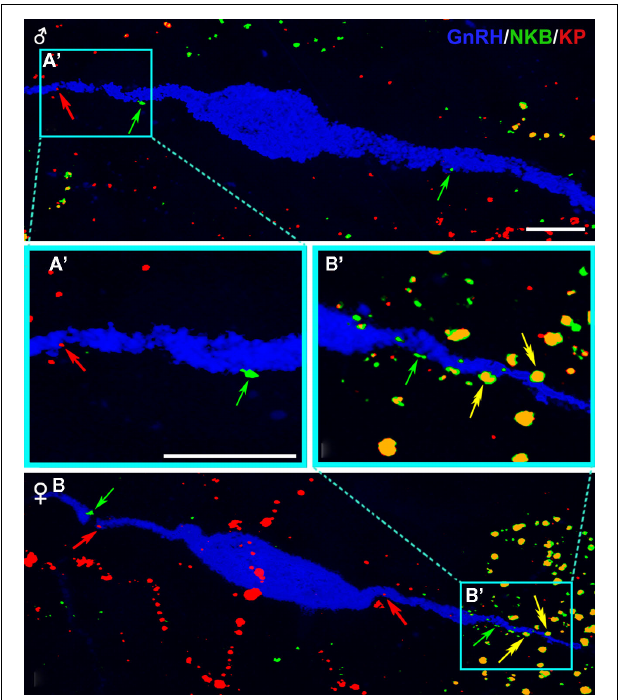
FIGURE 8 | Detection of preproNKB and kisspeptin immunoreactivities in neuronal appositions onto GnRH neurons of the Inf. The simultaneous immunofluorescent detection of preproNKB (green color), kisspeptins (red color), and GnRH (blue color), followed by confocal analysis revealed direct appositions of single- and double-immunolabeled (yellow color) axons onto GnRH-IR cell bodies and dendrites. Note in stacks of optical slices that preproNKB/kisspeptin dual-IR appositions (yellow) are more typical in postmenopausal female [ (B) and high-power image of the framed dendritic region (B (cid:2) ) ] than in aged male [ (A) and high-power inset (A (cid:2) ) ] subjects. Red and green arrows indicate afferent contacts that are single-labeled for kisspeptins and preproNKB, respectively, whereas yellow double-arrows indicate double-labeled appositions. For quantitative results of sex comparisons, see Figure 9 . Scale bars = 10 μ m [Bars in (A,A (cid:2) ) also refer to (B,B (cid:2) ) , respectively].